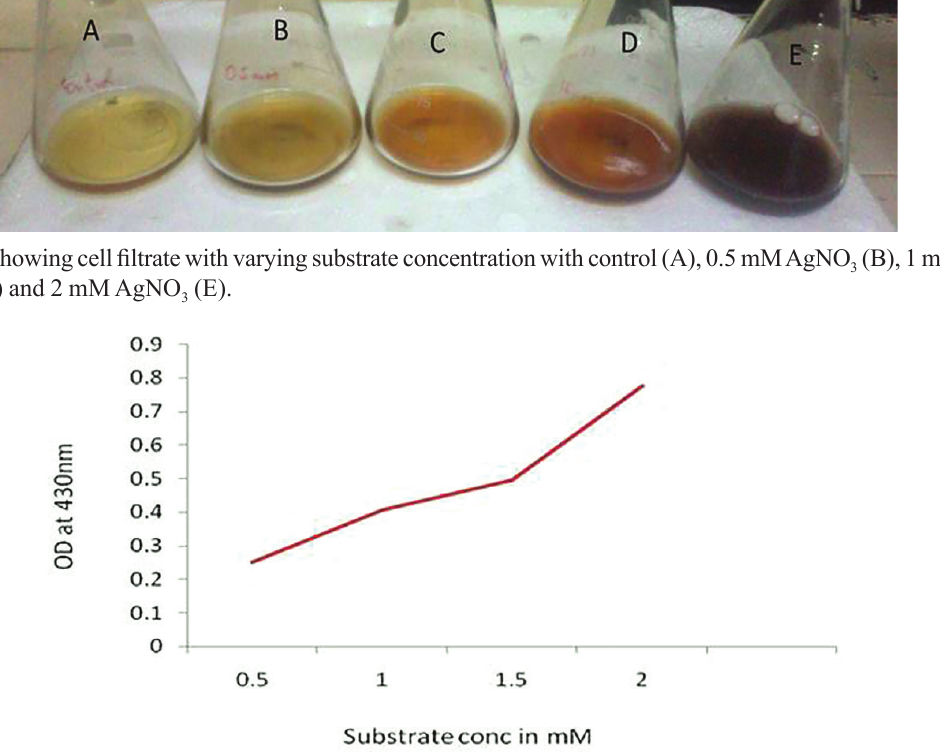
FIGURE 4 - Effect of substrate concentration on AgNO